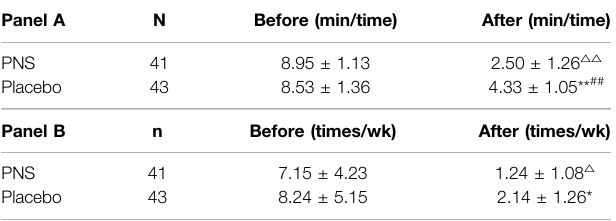
TABLE 3 | (Panel A) Length of angina attacks; (Panel B) Frequency of angina attacks. Panel